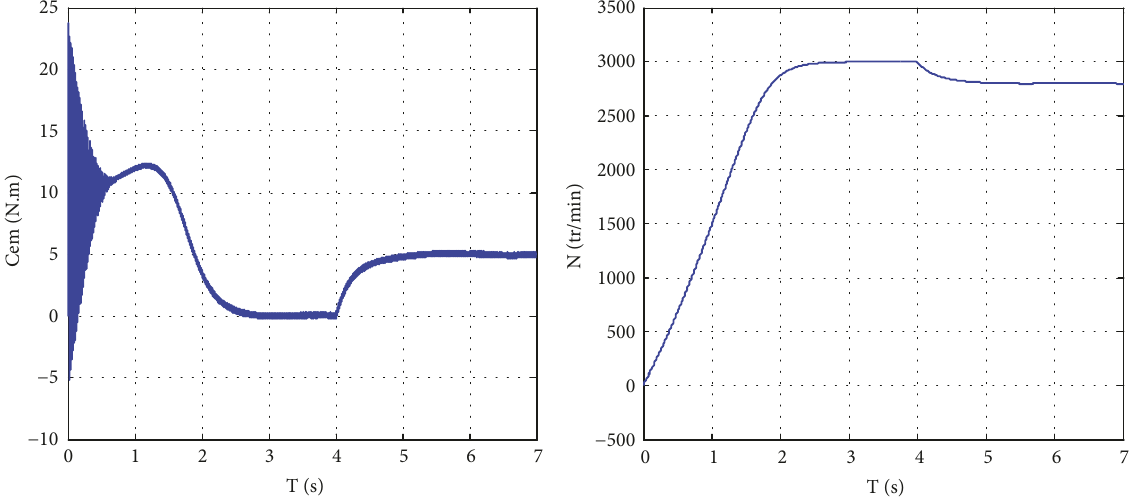
Figure 10: Electromagnetic torque and rotational speed for m = 7.